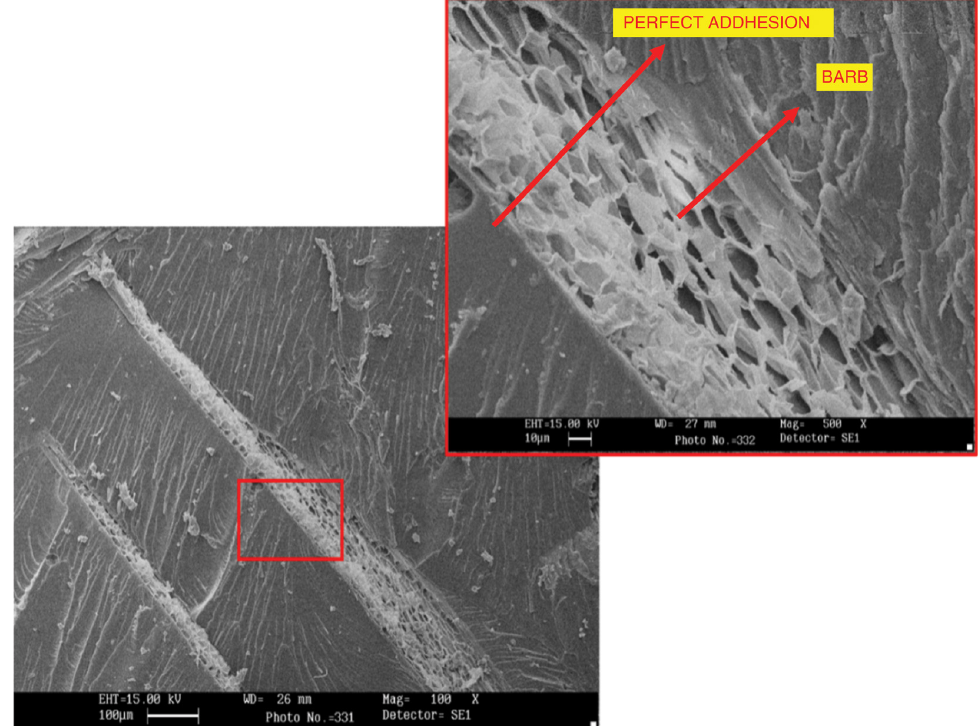
Figure 7: Scanning electron micrograph for 1.0% CR and 5.0% CFF composite.